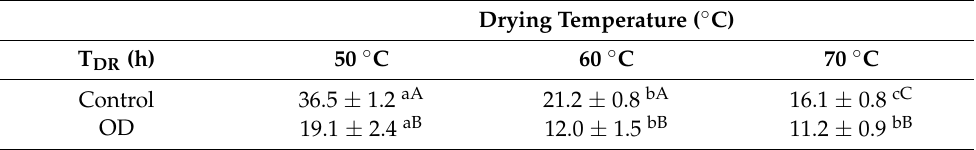
Table 3. Total air-drying time for control and OD-pretreated fig halves at 50, 60, and 70 ◦ C drying